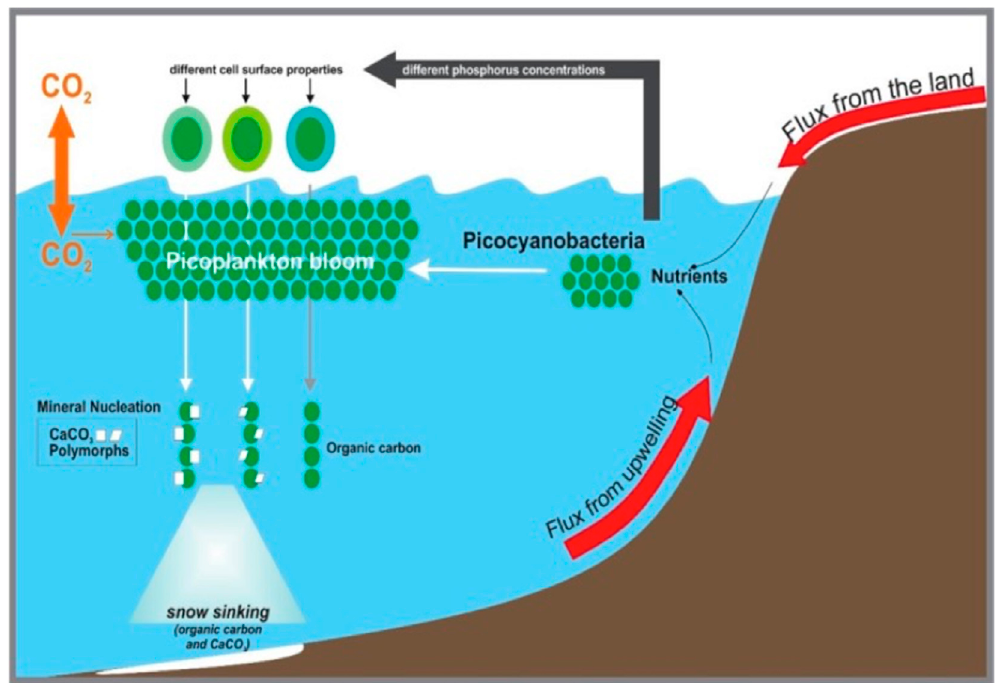
Figure 7. Conceptual model of the contribution of cyanobacteria envelopes to authigenic calcium carbonate formation in environments spiked with nutrients.